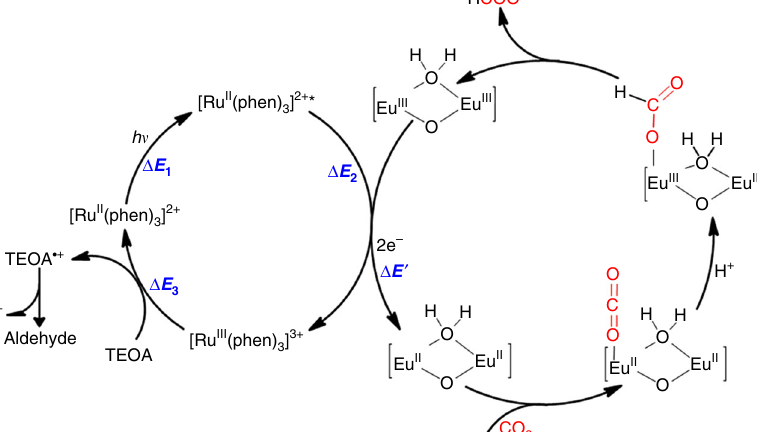
Fig. 8 Proposed catalytic mechanism of photocatalytic CO 2 reduction to HCOOH. The photo-initiated electron transfers from Ru photocenters to dinuclear Eu 2 oxo-clusters in Eu-Ru(phen) 3 -MOF lead to the photo-reduction of CO 2 . Δ E 1 = 2.07 eV, Δ E 2 = − 0.88 eV, Δ E 3 = − 1.19 eV, and Δ E ’ = − 0.69